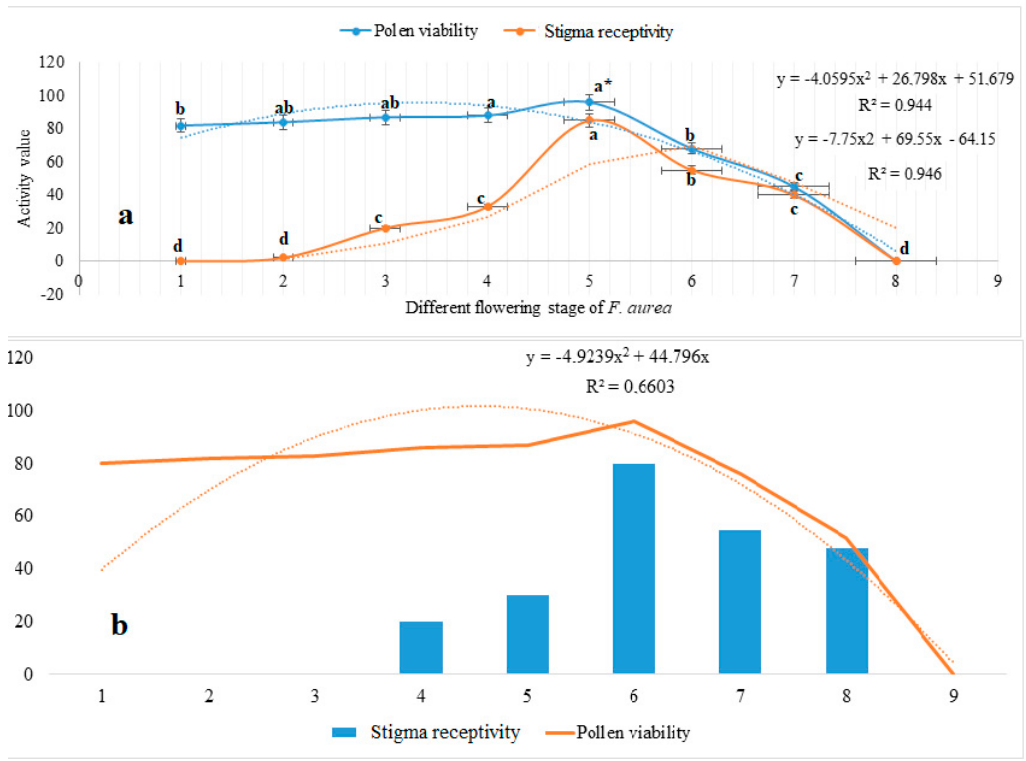
Figure 4. Pollen viability and stigma receptivity of F. aurea ; * Means on charts followed by the lowercase letters differ significantly between different flowering stages of F. aurea for pollen viability and stigma receptivity at 0.05 level based on adjusted p-values using Tukey HSD test ( a ). Correlation between pollen viability and stigma receptivity ( b ).